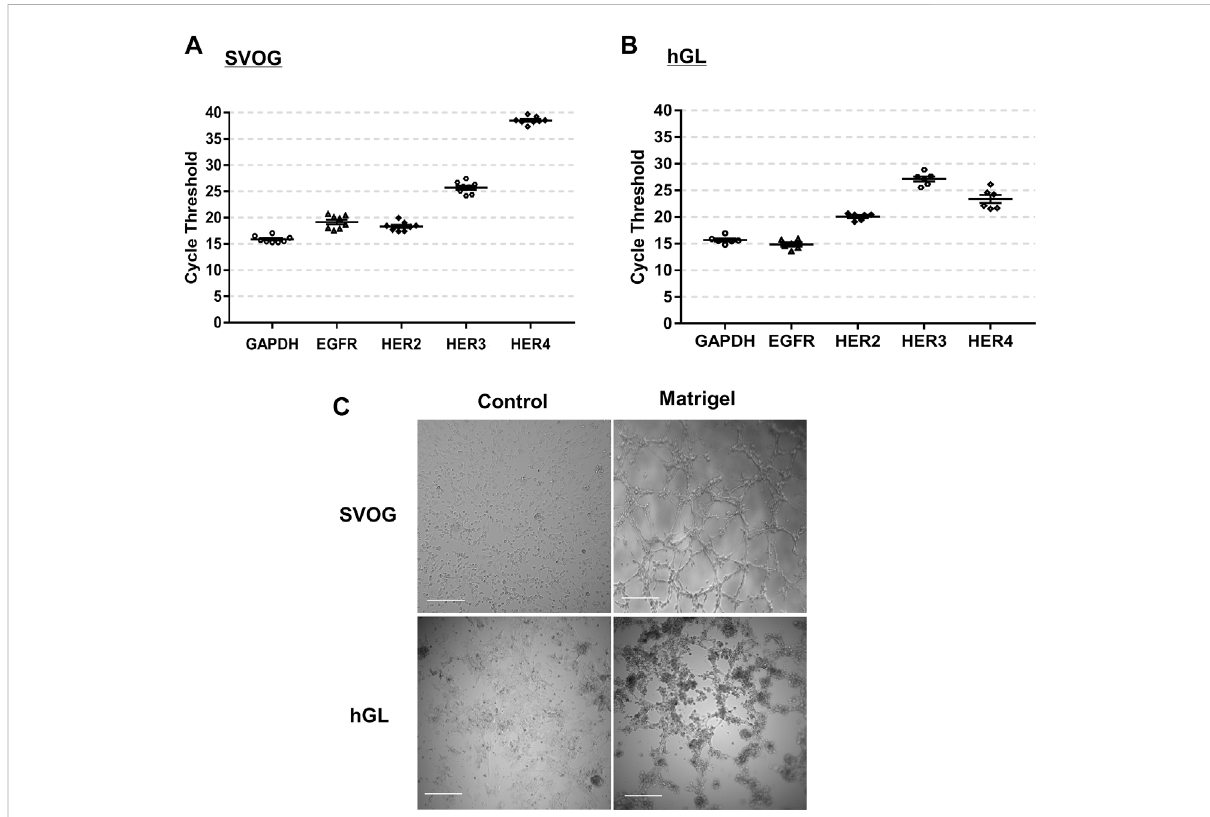
FIGURE 1 ExpressionofEGF-likegrowthfactorreceptorsandmicrovasculature-likenetworkformationinhGLcells. (A,B) GAPDH,EGFR,HER2,HER3and HER4 expressions in SVOG [ (A) , n = 8] and primary hGL cells [ (B) , n = 6] were assayed by RT-qPCR. The distribution of the cycle threshold values is presented after the RT-qPCR. (C) In the microvascular-like formation assay, SVOG and primary hGL cells were cultured on non-Matrigel- and Matrigel-precoated plates for 5 h. Images were taken by a microscope. Scale bars:100